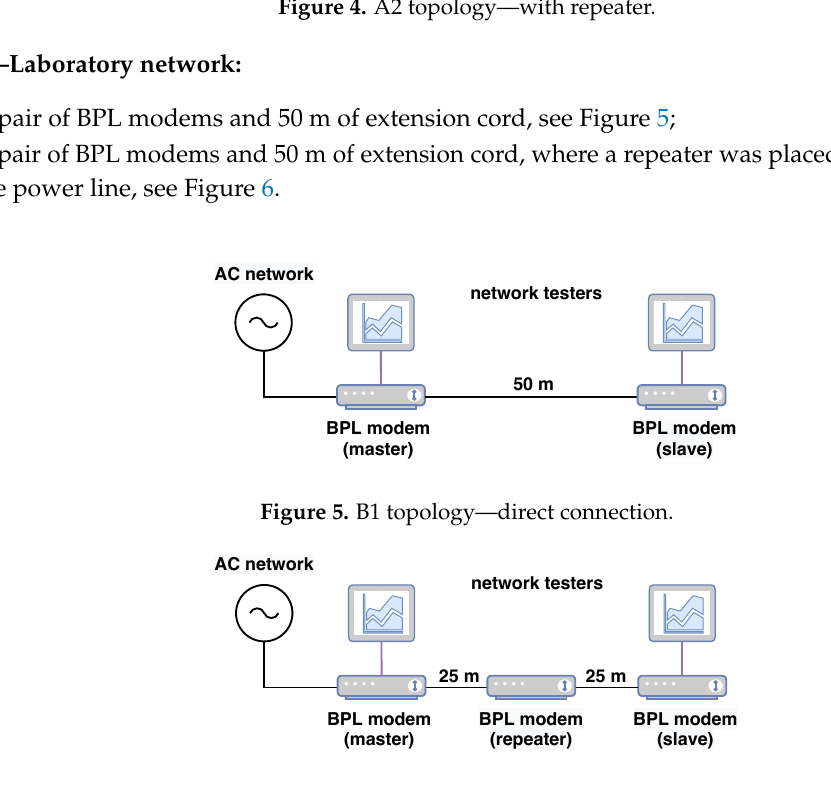
Figure 6. B2 topology—with